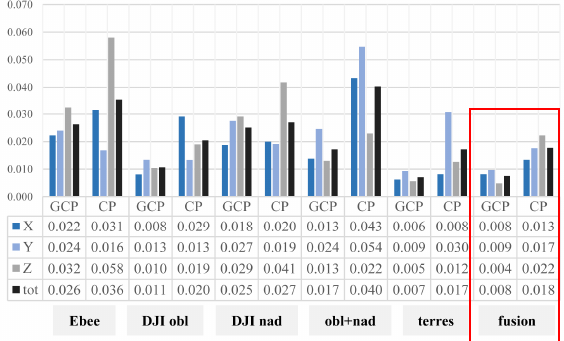
Table 1. Accuracy on RMSE (m) GCP and CP on